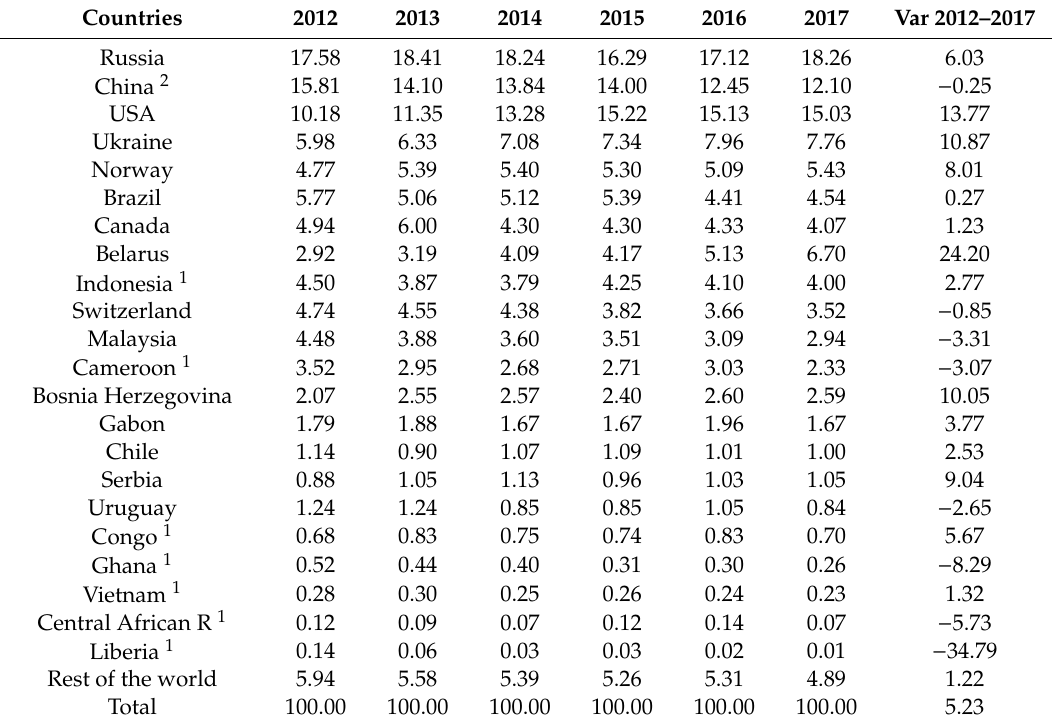
Table 4. Distribution by country of origin of timber and timber product imports from outside the EU-28 and cumulative average growth rate, 2012–2017